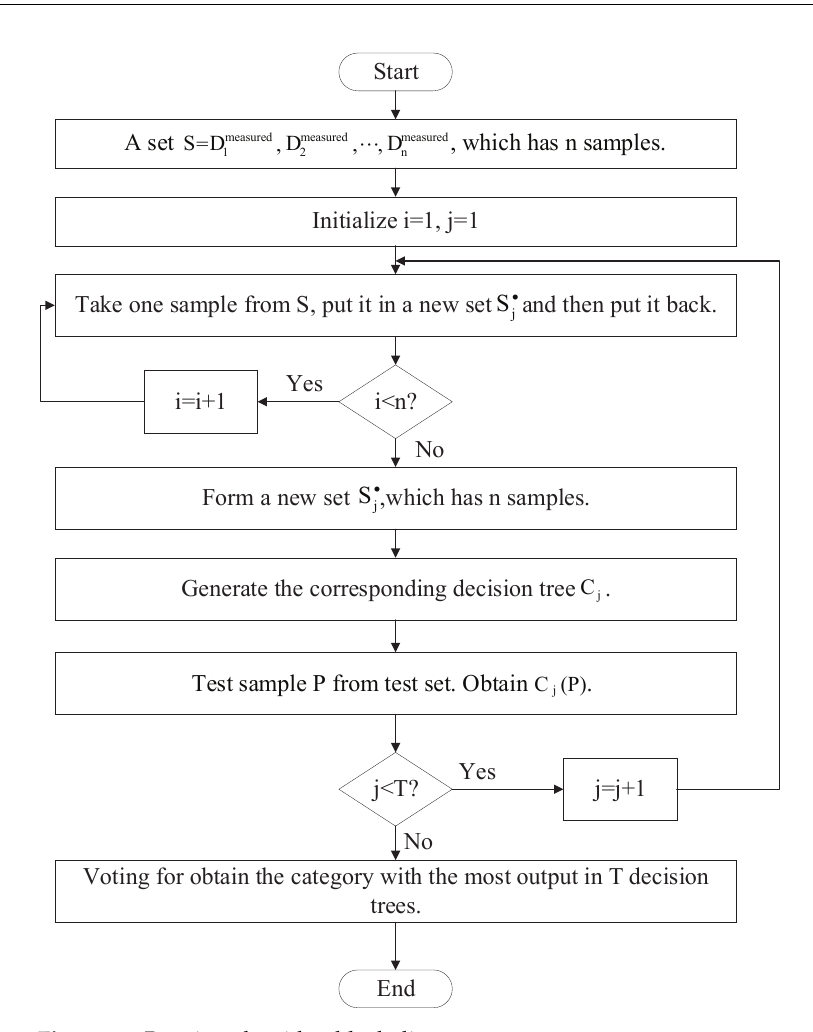
Figure 14. Bagging algorithm block